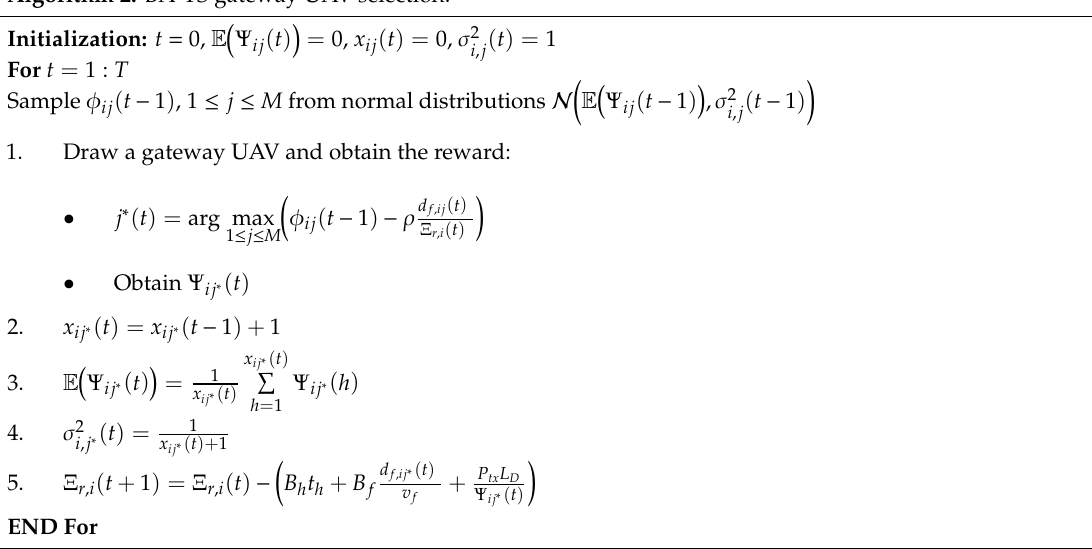
Algorithm 2: BA-TS gateway UAV